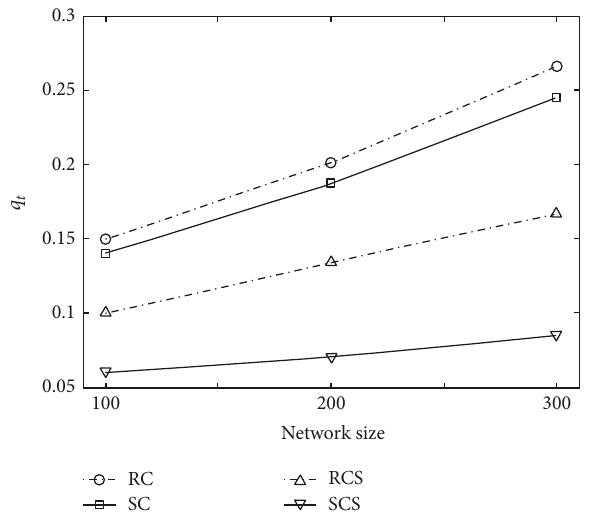
Figure 4: Comparison between practical degree distribution and theoretical distribution.